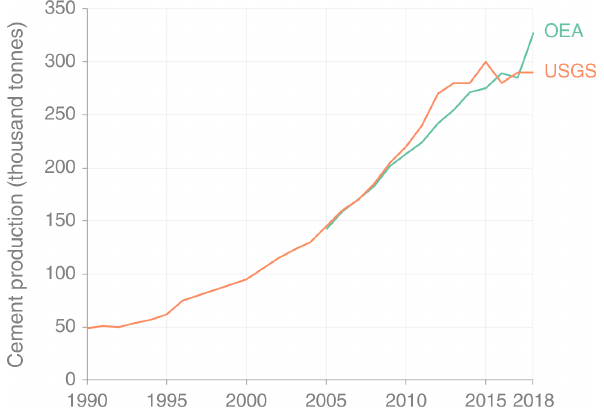
Figure C6. Comparison of Indian cement production data from USGS and OEA, the latter beginning in 2005.